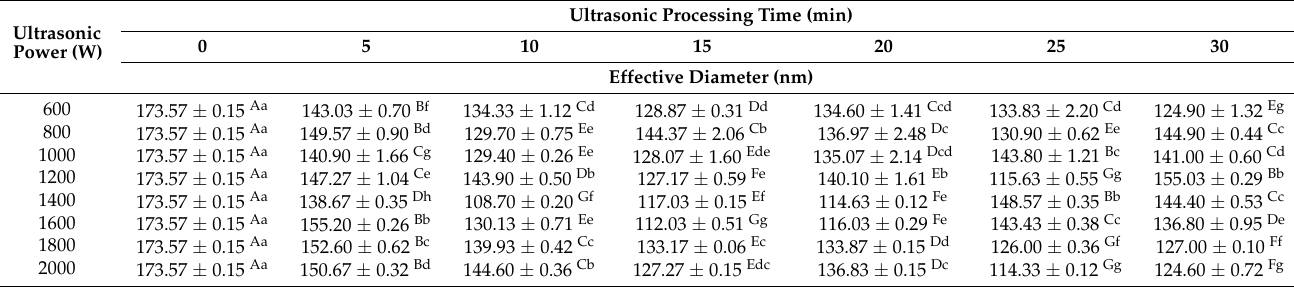
Data are the averages of three replications ± standard deviation. A–G: Different uppercase letters mean significant difference in comparisons between ultrasonic processing time (0, 5, 10, 15, 20, 25, and 30 min) for each power at p < 0.05. a–g: Different lowercase letters mean significant differences between ultrasonic power (600, 800, 1000, 1200, 1400, 1600, 1800, and 2000 W) for each processing time at p <